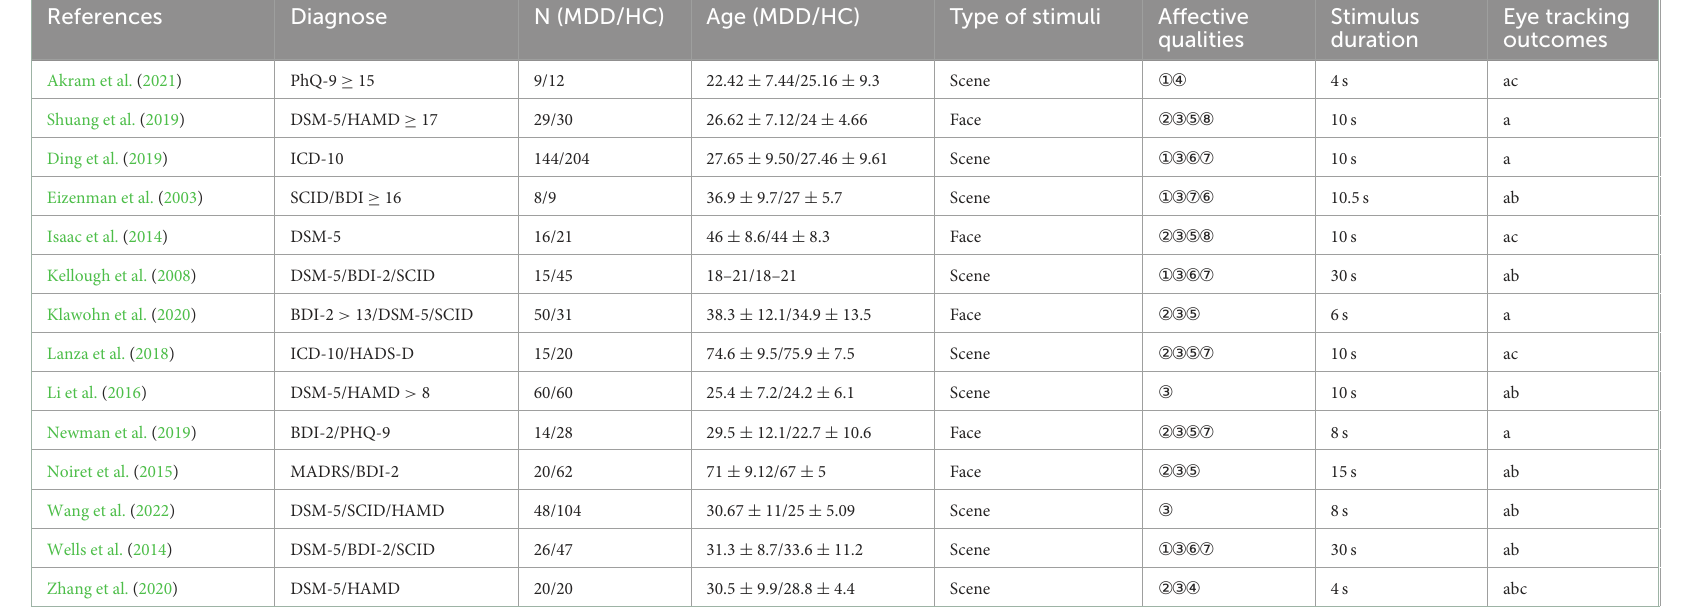
TABLE 1 Studies included in the